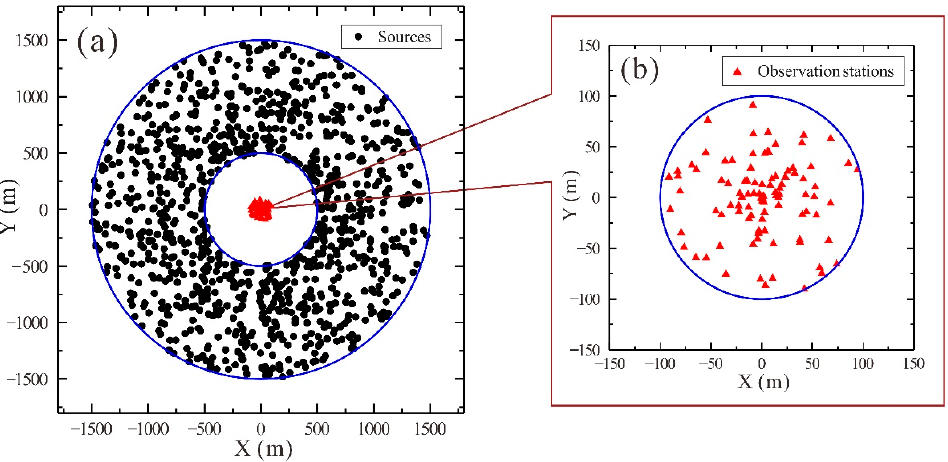
Figure 1. Spatial distribution diagram of random sources and observation array: ( a ) random sources; ( b ) observation array.